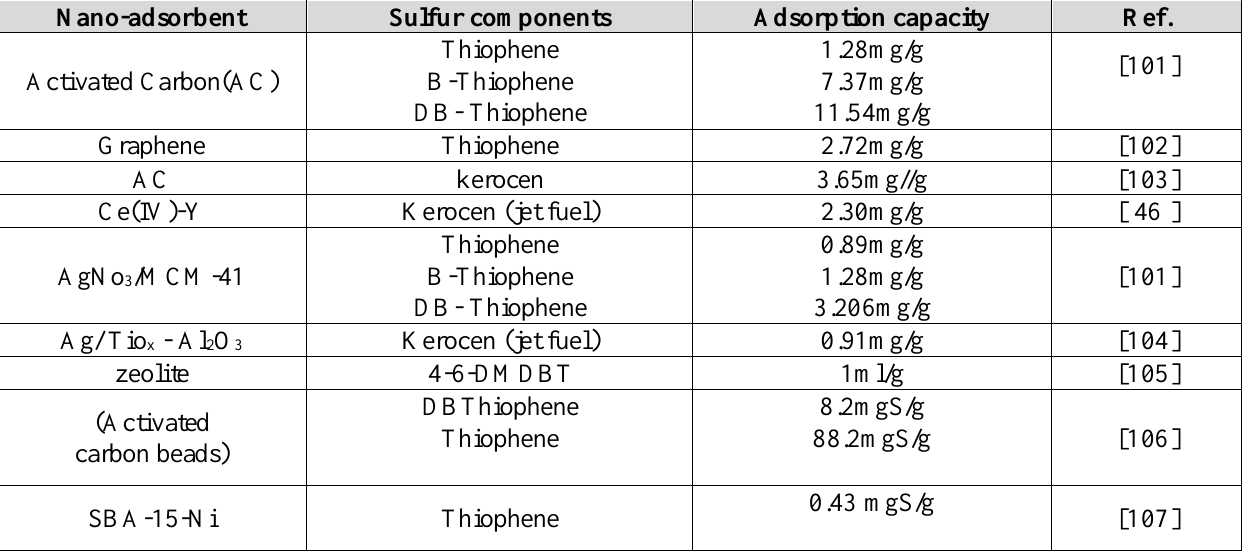
Table 1 : Nano-materials in the adsorption desulfurization process.